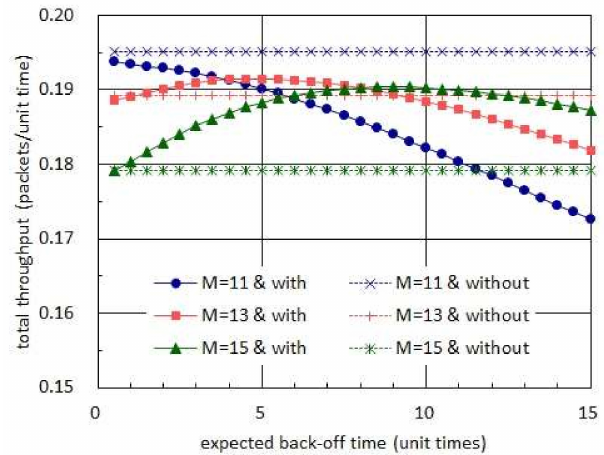
Figure 9. Comparison of total throughputs achieved with and without taking back-o ff